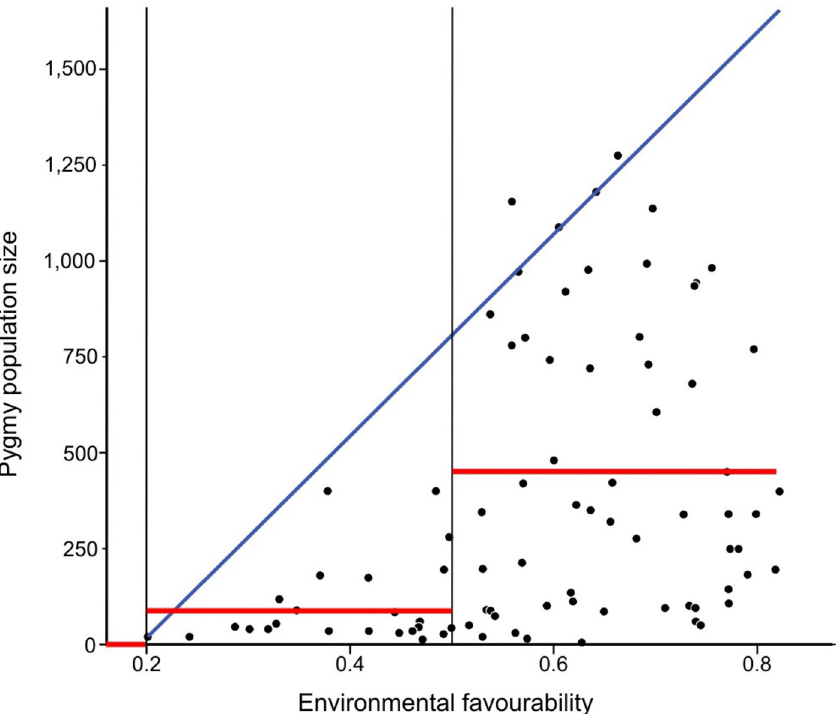
Fig 2. Space defined by predicted environmental favourability (x-axis) and population size (y-axis). The scatter plot shows a polygonal wedge-shaped spread of points with the upper limit increasing at higher favourability values. The blue line fits the quantile regression with the 95th percentile, representing the upper limit of potential population size. Red lines indicate average population size considered, in every favourability category ( < 0.2, 0.2–0.5, > 0.5), for estimating net potential population size in the Central African studied